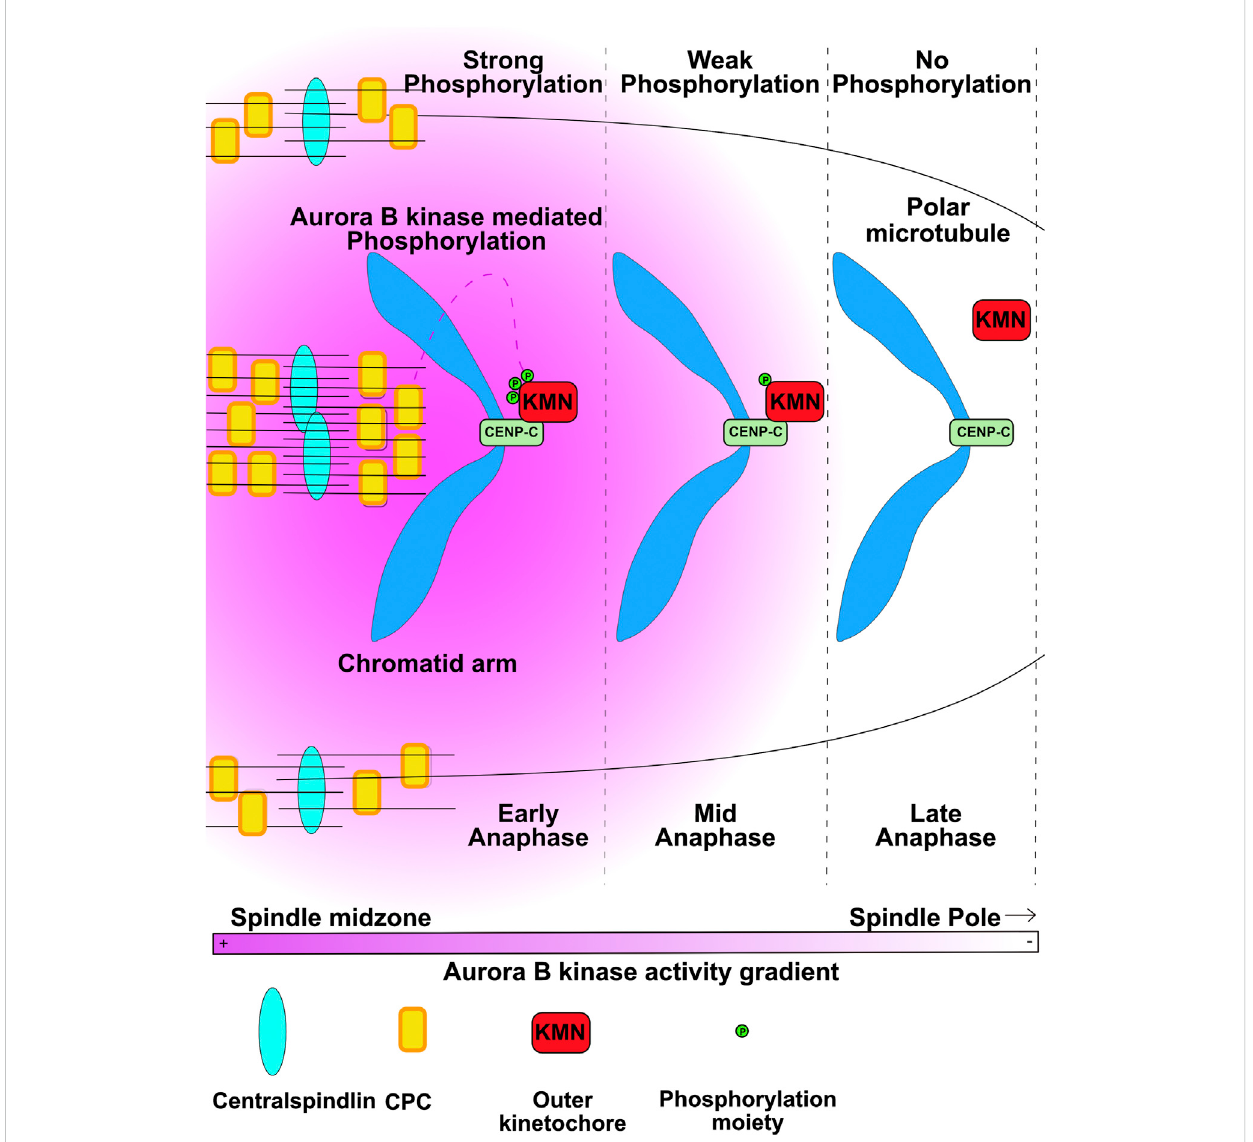
FIGURE 3 Kinetochores disassembly is controlled by chromosomes traversing from regions of high Aurora B activity to low activity. Aurora B kinase phosphorylates the DSN1 subunit of KMN (KMN) to allow KMN to bind the CENP-C protein to assemble kinetochores. As segregating chromatids are pulled to areas of low Aurora activity the KMN proteins are dephosphorylated and kinetochores disassemble. Figure representation: Chromosome arms, Blue; CENPC, light green rectangles; KMN, red rectangles; Phosphorylation moiety, green circles, Microtubules, black lines; Central Spindlin complex, Blue ovals; CPC, yellow rectangles; Pink heat map represents Aurora B kinase activity gradient. Abbreviation: CPC, Chromosomal Passenger Complex; KMN, KNL1-Mis12-Ndc80 outer kinetochore complex. Figure adapted from Papini et al.